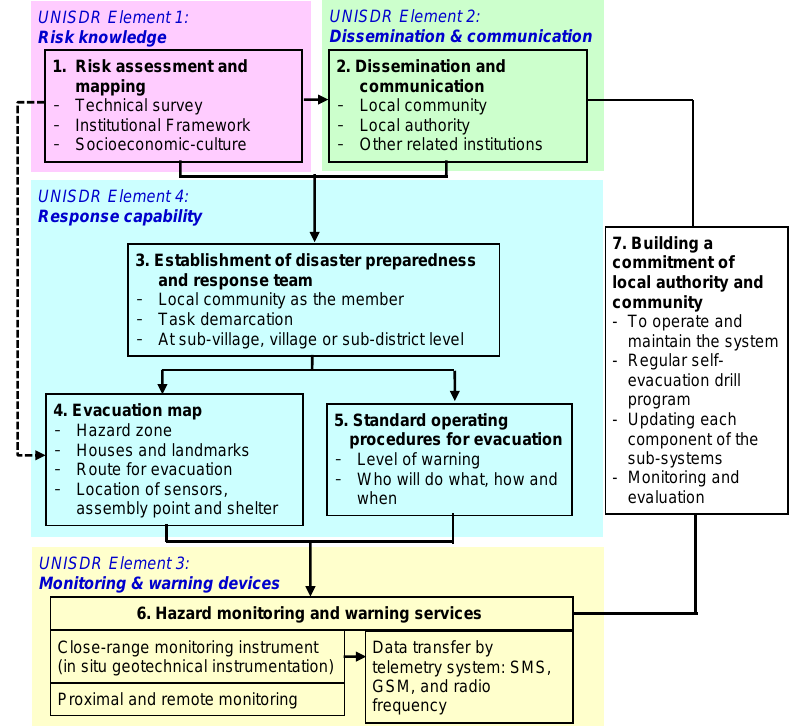
Figure 1. The newly proposed seven sub-systems for landslide early warning systems as the extraction of four key elements of a people- centered early warning system by UN-ISDR